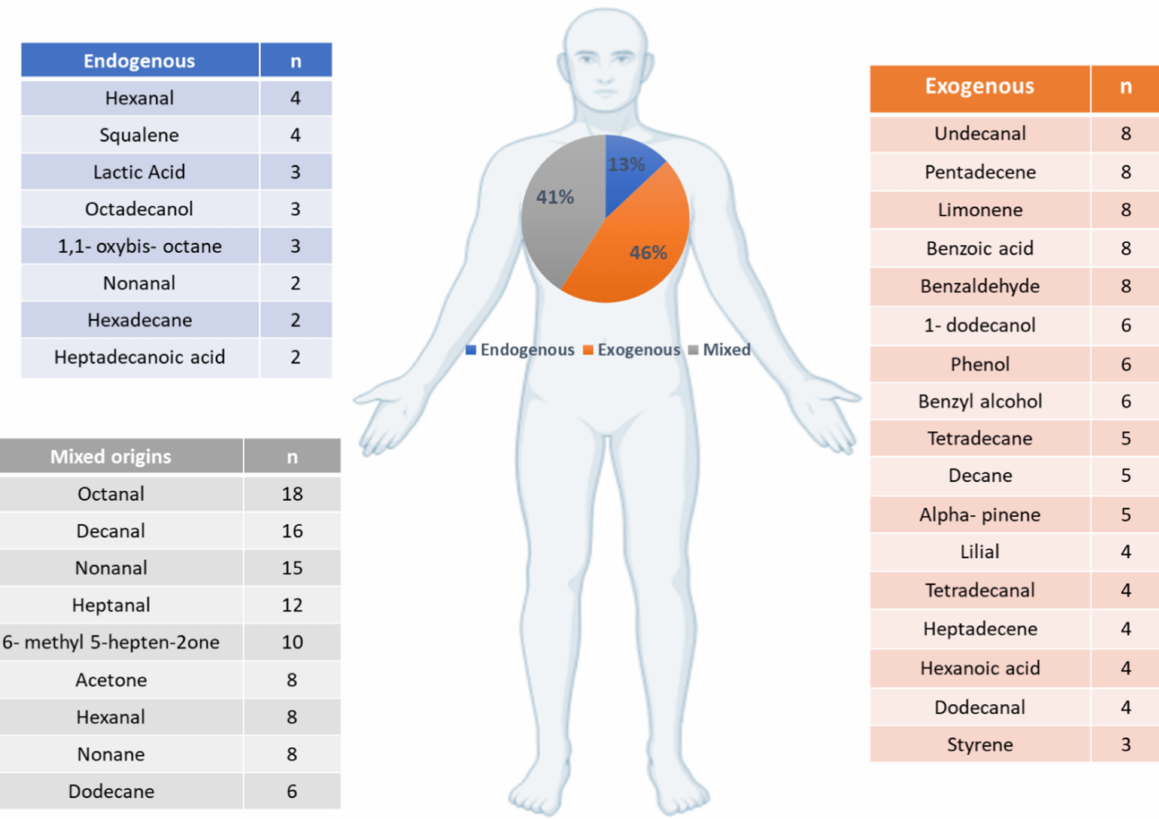
Figure 3. The putative biological origins of skin volatile organic compounds emitted from human skin. The putative biological origins of the compounds representing the healthy human skin volatolome, grouped into endogenous, exogenous, and mixed origins. The most common compounds in each category are included; n represents the number of papers each compound was identified